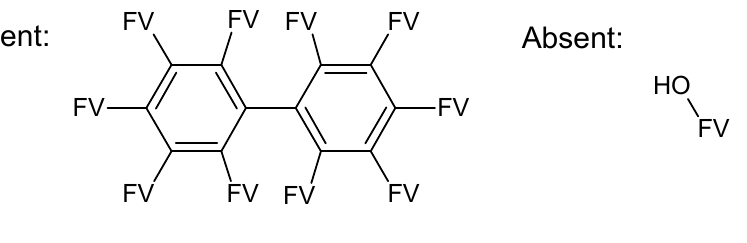
Figure A14. Substructures for GC–MS Challenge 15. FV = free valence.